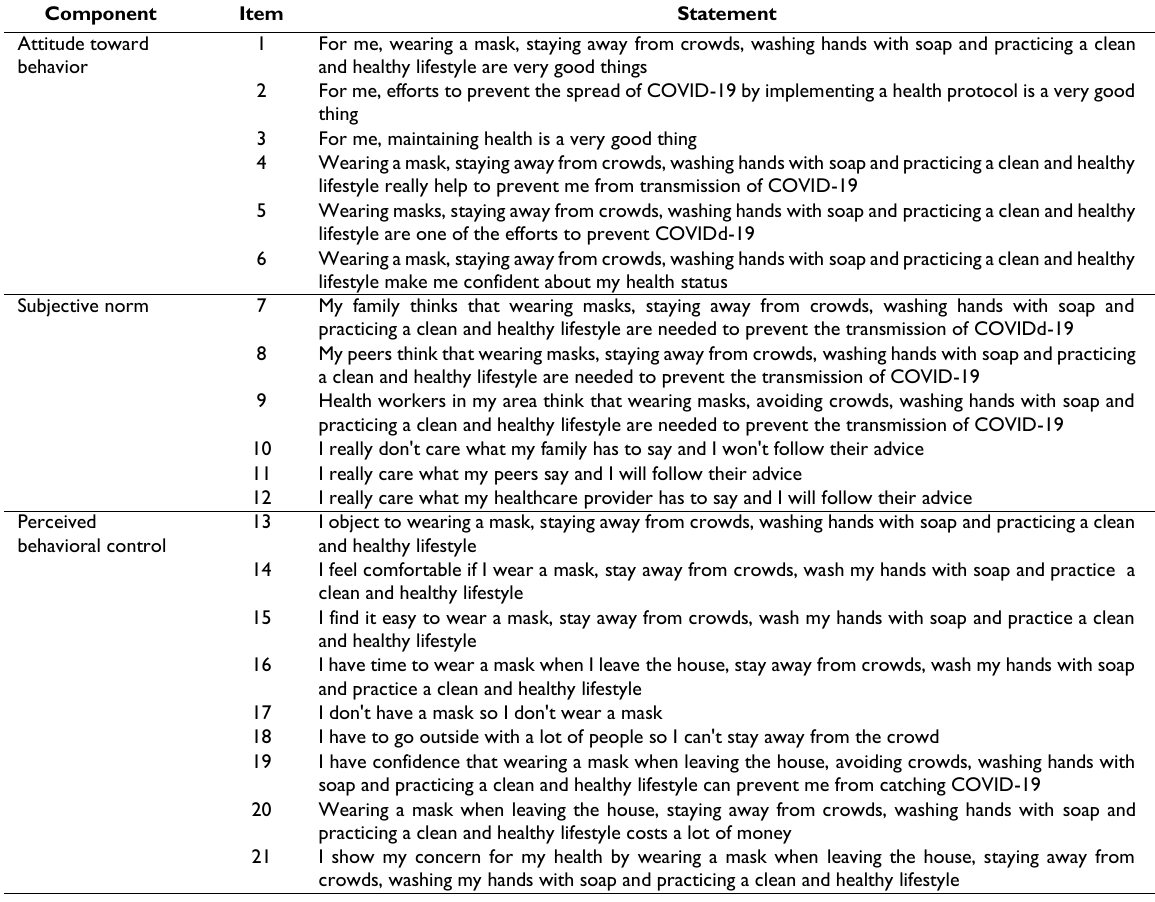
Table 1 21-item Theory of Planned Behaviour questionnaire Component Item Statement Attitude toward behavior